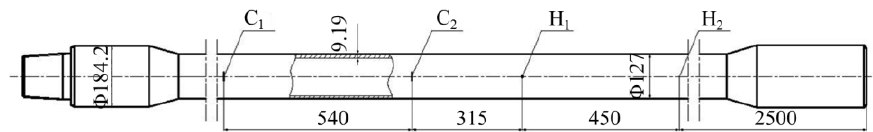
Figure 16. The drill pipe sample with four defects (unit: mm).